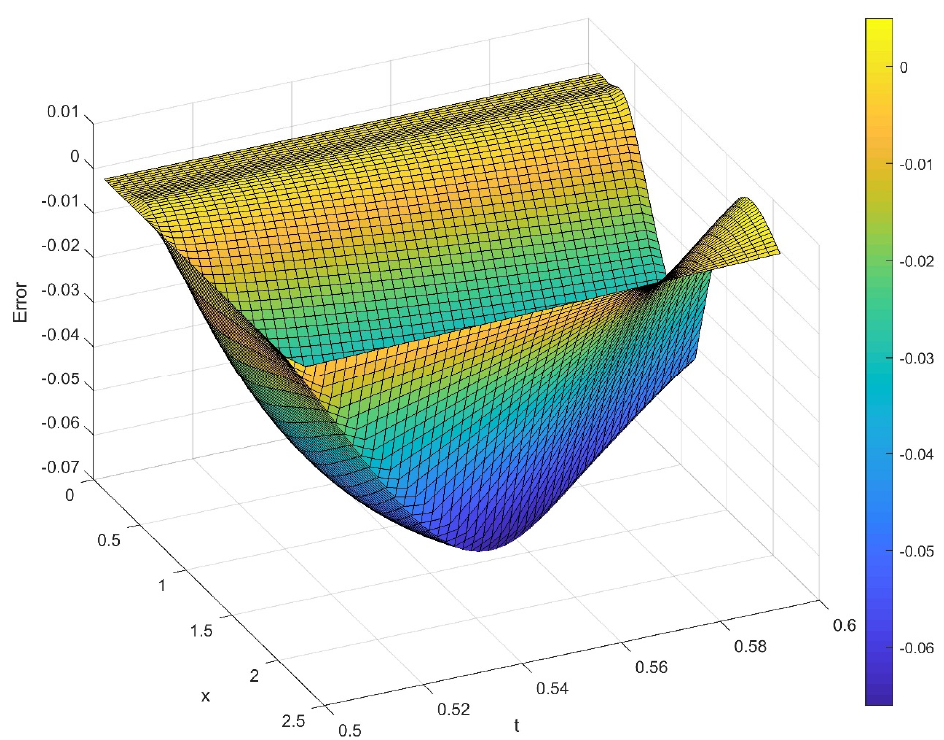
Figure 7. The difference between the analytical solution and the LH method for h = 0.0021 as a function of space and time for Experiment 1. Table 2. Errors and numerical order of different algorithms for Experiment 2.